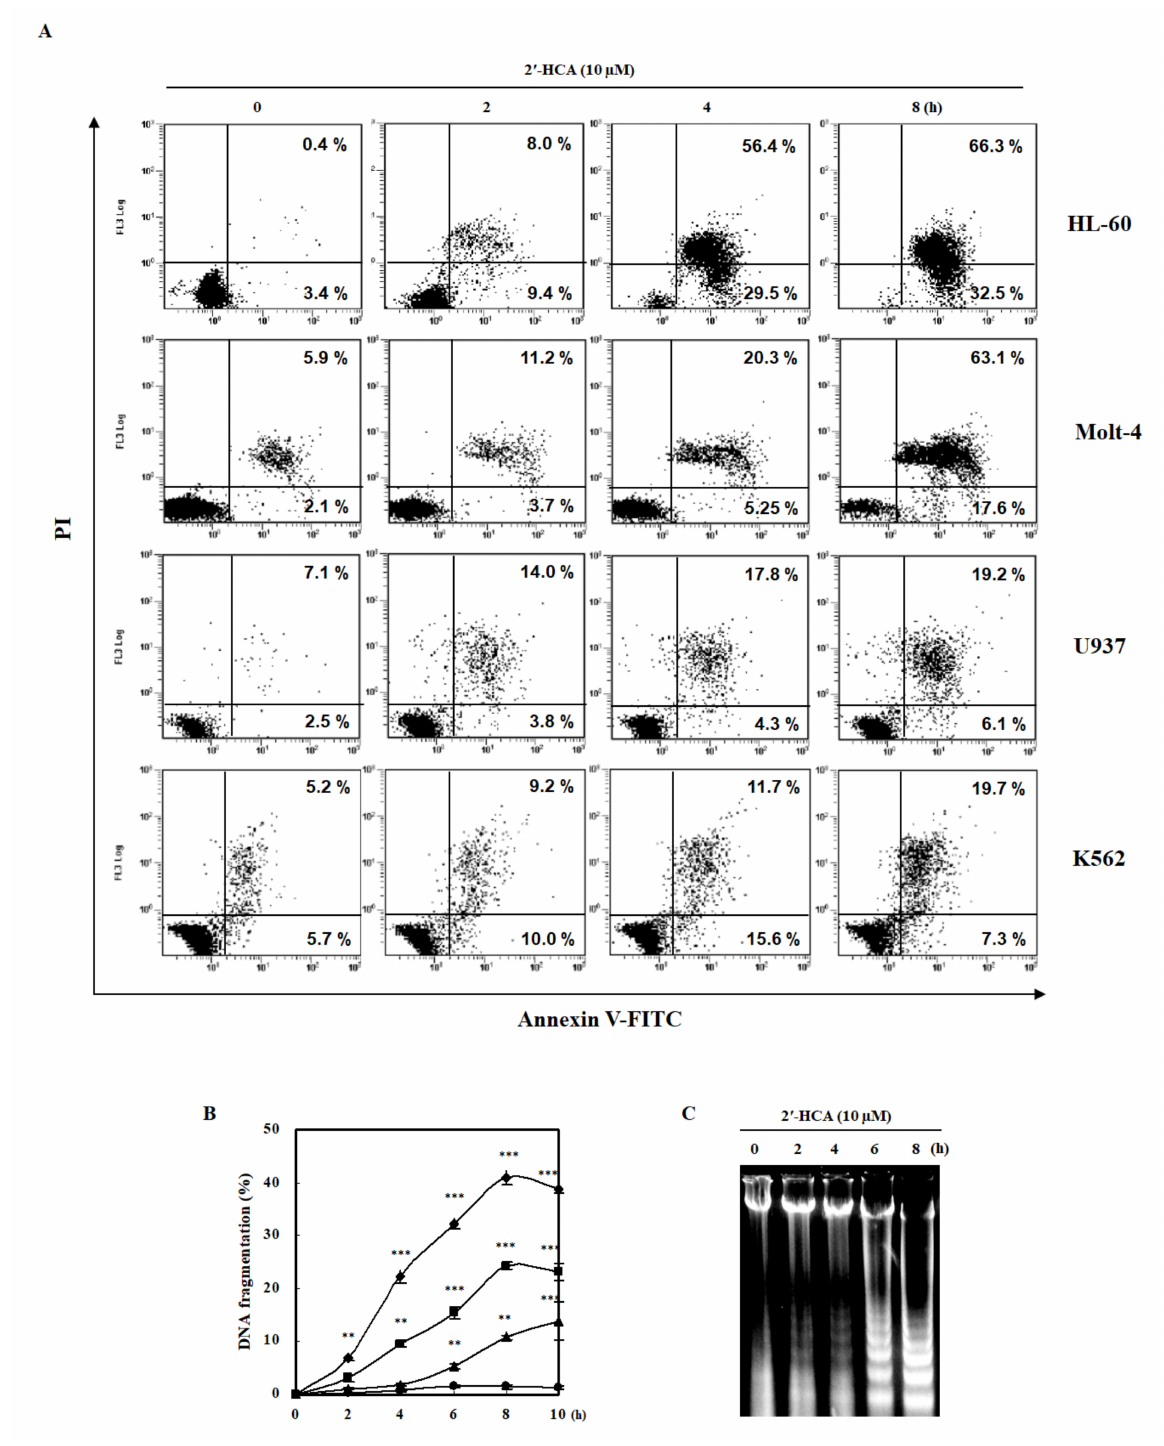
Figure 3. Effects of 2 (cid:48) -HCA on the induction of apoptosis and DNA fragmentation in HL-60 cells. ( A ) HL-60 cells were co-stained with Annexin V-FITC/PI after treatment with 10 µ M 2 (cid:48) -HCA to detect the externalization of phosphatidylserine (PS) followed by flow cytometric analysis. HL-60 cells were treated with 10 µ M 2 (cid:48) -HCA for the indicated period, and the extent (%) of DNA fragmentation was determined by ( B ) DAPI assay and ( C ) agarose gel electrophoresis as described in the Section 2. Data are presented as the mean ± SD of three independent experiments ( • , 0 µ M; (cid:78) , 2.5 µ M; (cid:4) , 5 µ M; (cid:7) , 10 µ M 2 (cid:48) -HCA). ** p < 0.01 and *** p < 0.001 vs. control